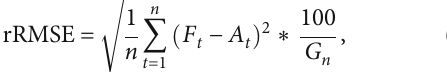
Table 3: rRMSE values in the case of four quanti fi ed situations of the V 10 days.